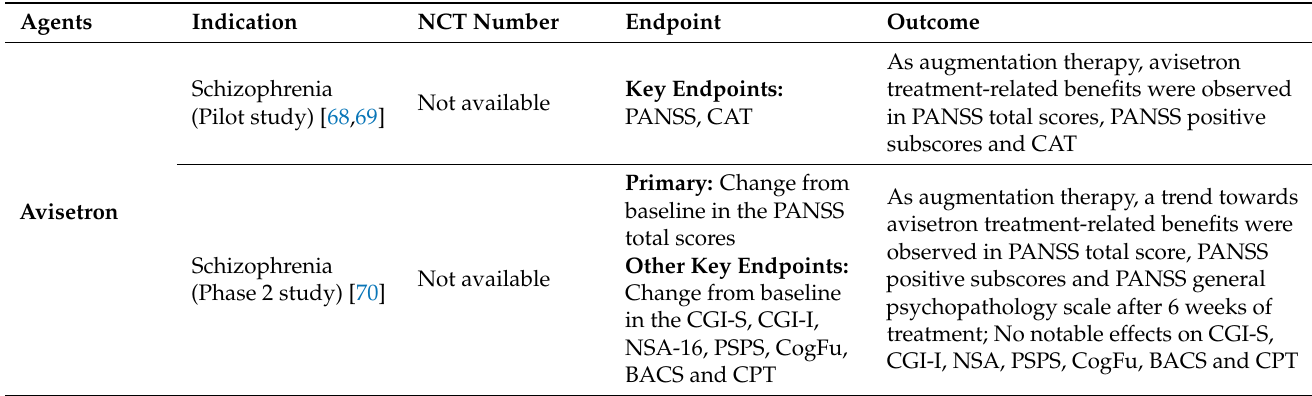
Table 3. Clinical Profile of 5-HT 6 Antagonists Recently in